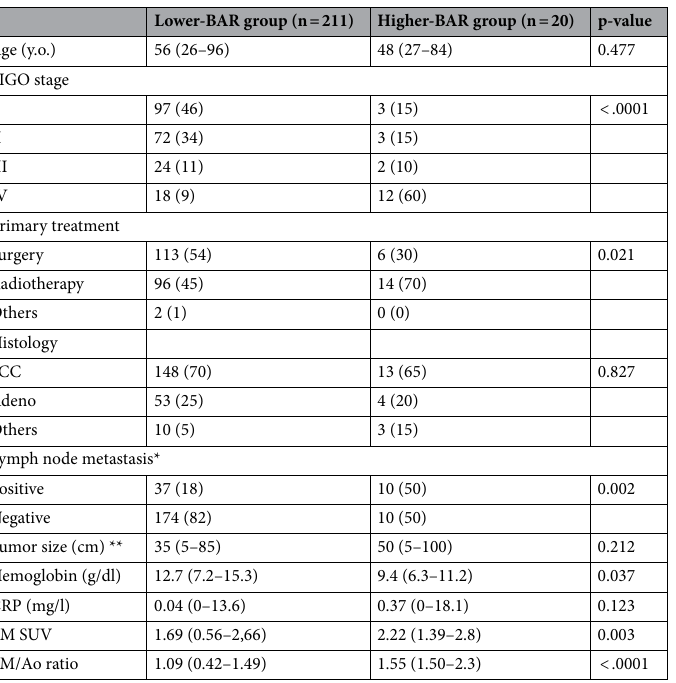
Table 1. Clinical characteristics of the lower- and higher-BAR group patients with cervical cancer. BAR, BM-to-Aorta ratio of FDG uptake; FIGO, International Federation of Gynecology and Obstetrics; SCC, squamous cell carcinoma; Adeno, adenocarcinoma; CRP, C-reactive protein; BM, bone marrow: SUV, standard uptake value; Ao, Aorta. *Lymph node metastasis assessed by FDG-PET/CT (SUV max > 2.5 was considered positive for metastasis). **Tumor diameter was measured three dimensionally based on T2-weighted MRI